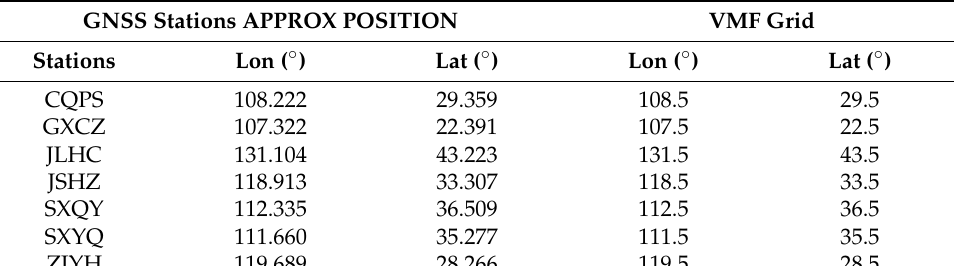
Table 3. Spatial information of approximate GNSS station positions and the VMF grid.